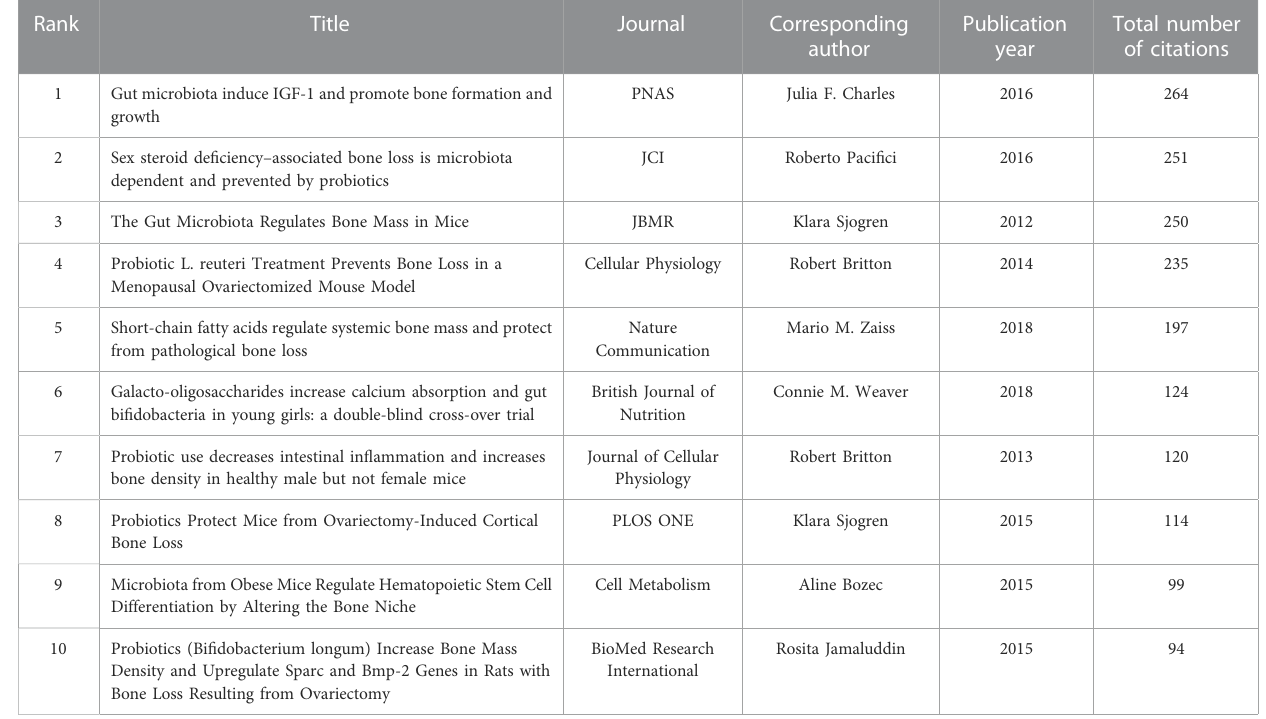
TABLE 4 The top 10 highest cited literature related to the